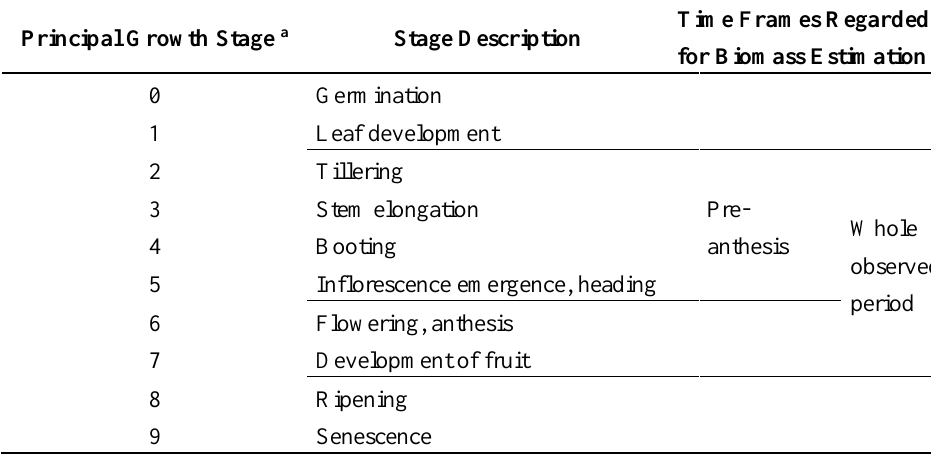
Table 2. Principal growth stages of the BBCH scale.